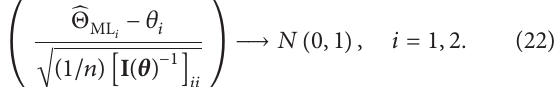
] → (1/𝑛)[ I ( 𝜃 ) −1 ] ML 22